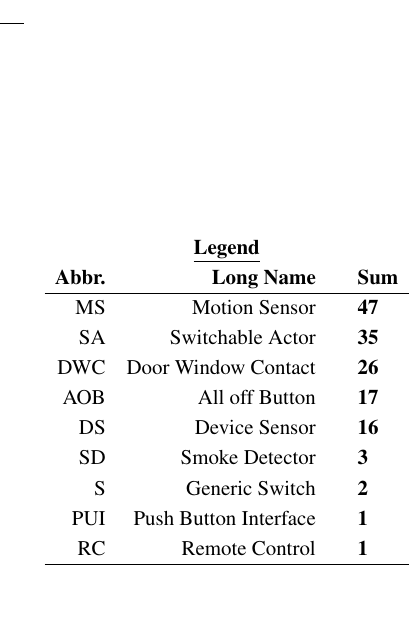
Table 2. Combination and number of devices installed in the participating households. Household Inhabitants No. of Devices Device Type and